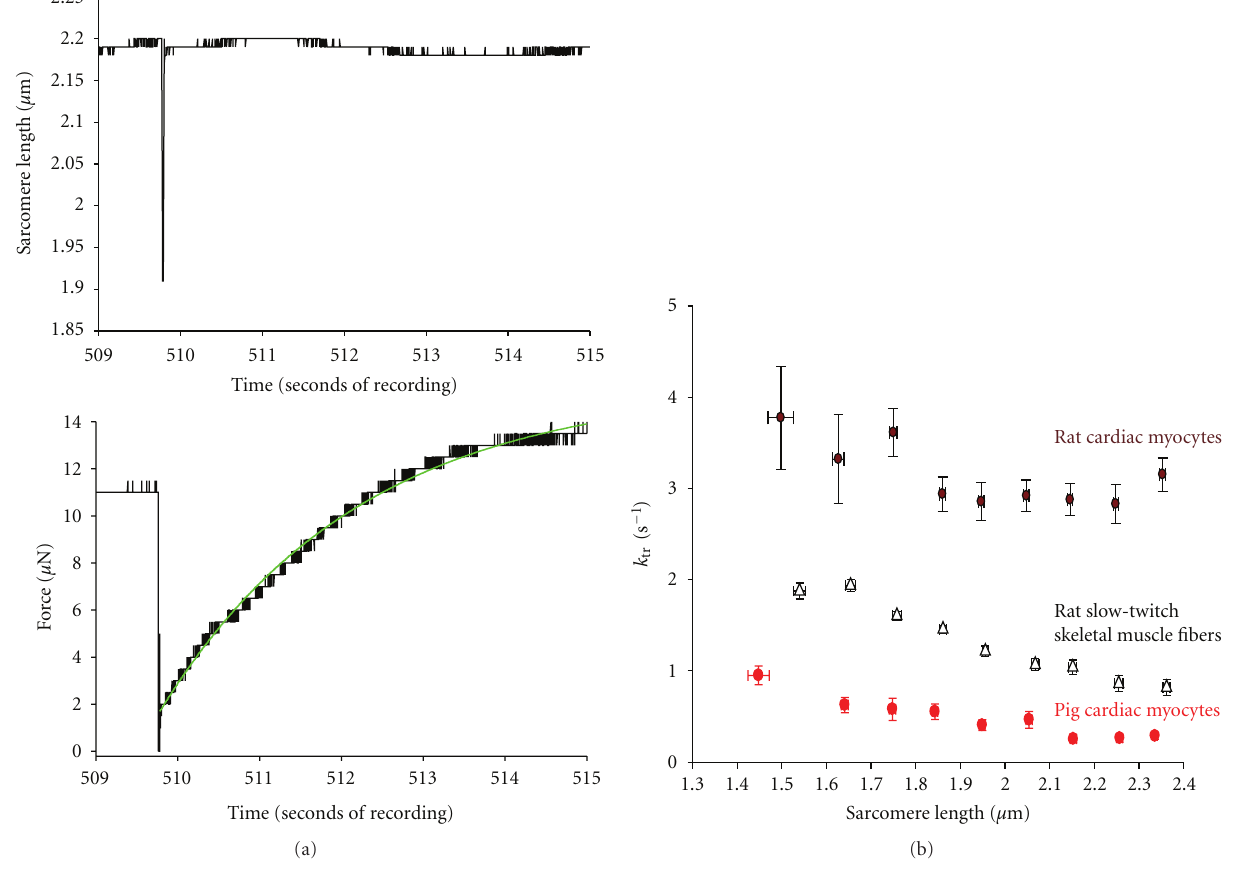
Figure 3: Sarcomere length dependence of the rate constant of force redevelopment ( k tr ). (a) Slow time-based recordings of sarcomere length and force obtained using an IonOptix SarLen system during a slack restretch maneuver during submaximal Ca 2+ activation. (b) Sarcomere length-dependence of k tr for rat slow-twitch skeletal muscle fibers, rat cardiac myocytes, and pig cardiac myocytes. Although pig cardiac myocyte k tr was much slower at all sarcomere lengths compared to rat cardiac myocytes, both pig and rat cardiac cell preparations showed that k tr increased at short sarcomere lengths despite reductions in force implicating that sarcomere length overrides the Ca 2+ activation dependence of k tr